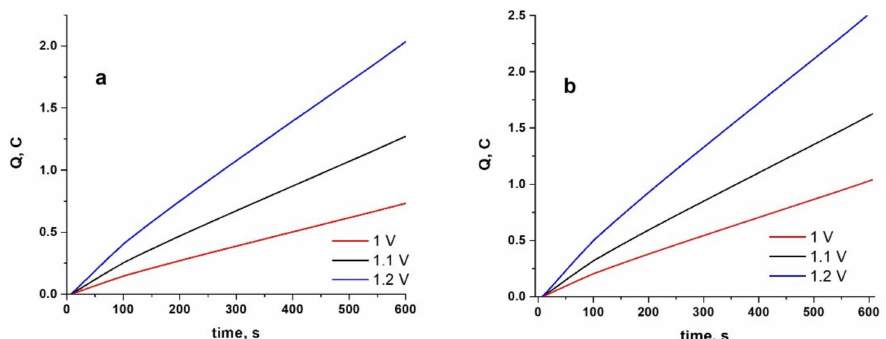
Figure 2. Charge-time plots during electrosynthesis of PPy at different constant potentials for 600 s on WBC ( a ) and Hera ( b ) CoCr alloys from ionic liquid electrolyte containing 0.5 M Py.